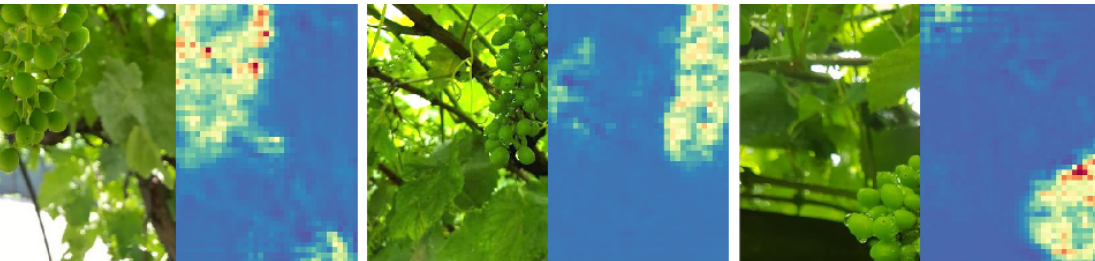
Figure 5. Examples of CR1 background regions incorrectly highlighted as berry by GBCNet. Overestimation errors are usually associated to patterns with a high variability in brightness and contrast.